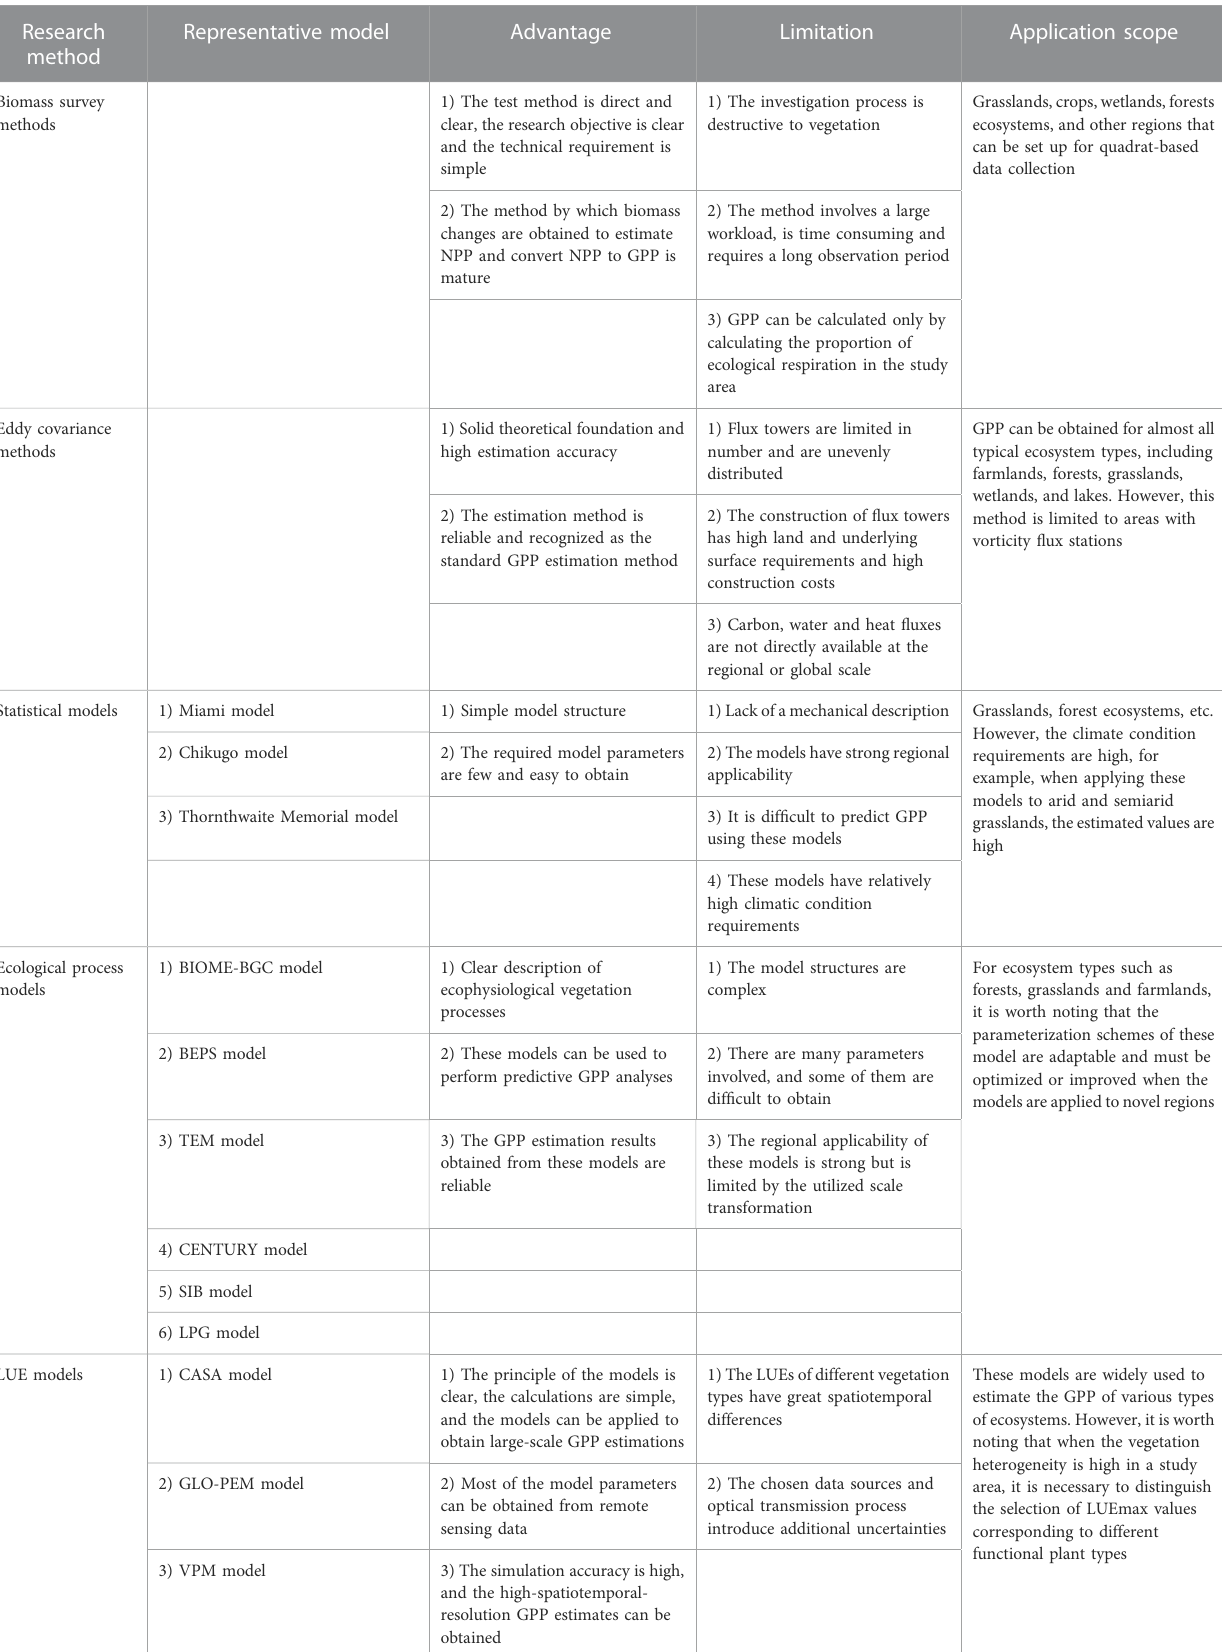
TABLE 5 Summaries of existing GPP research